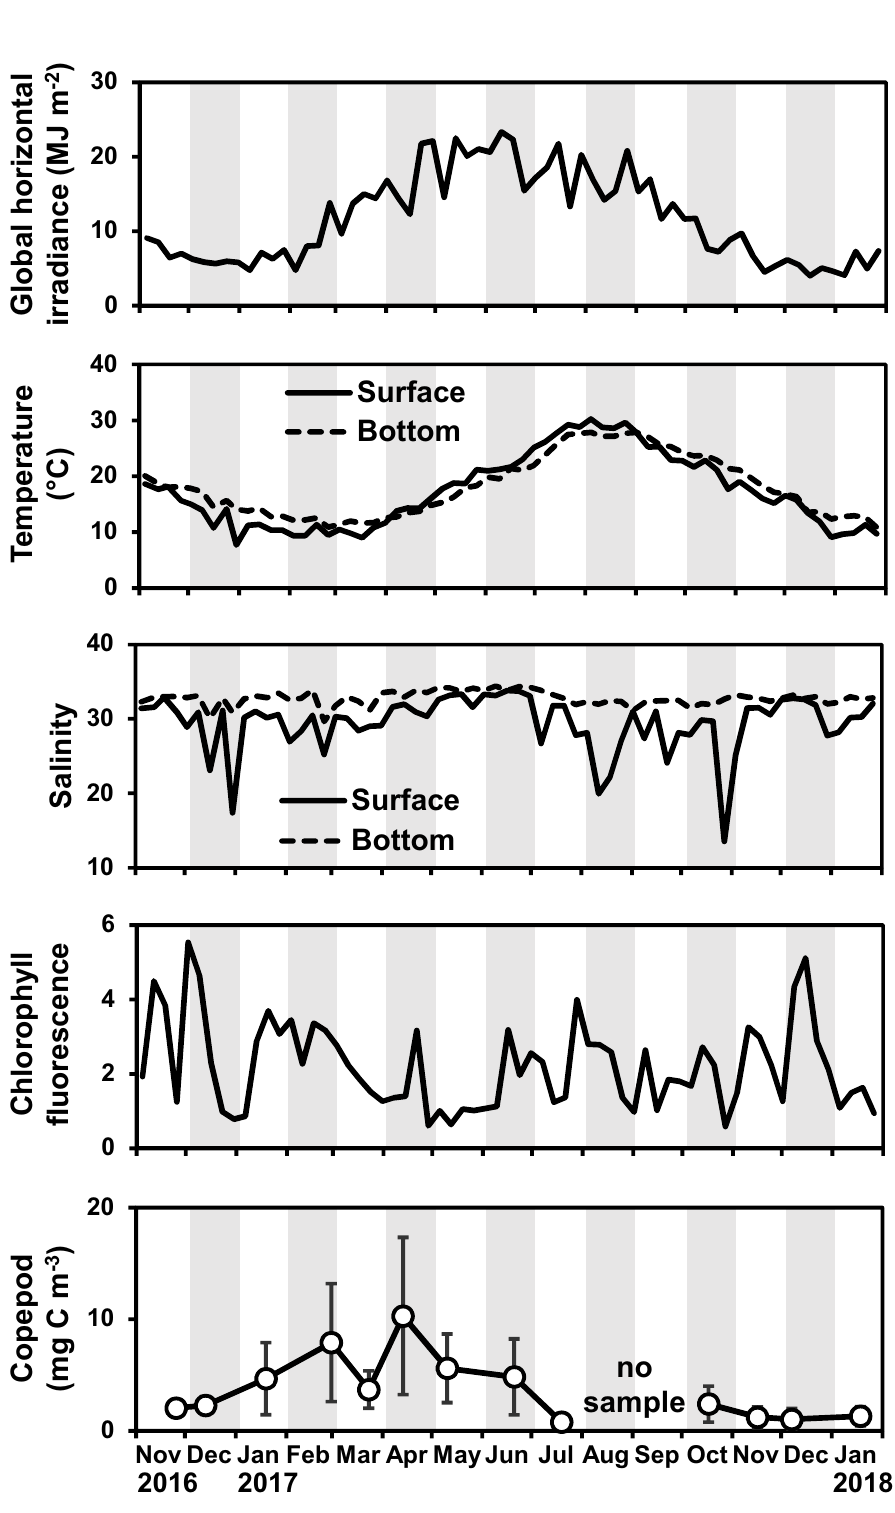
Fig 3. Temporal variations in environmental parameters. Chlorophyll fluorescence was averaged throughout the water column. Error bars in the copepod density indicate